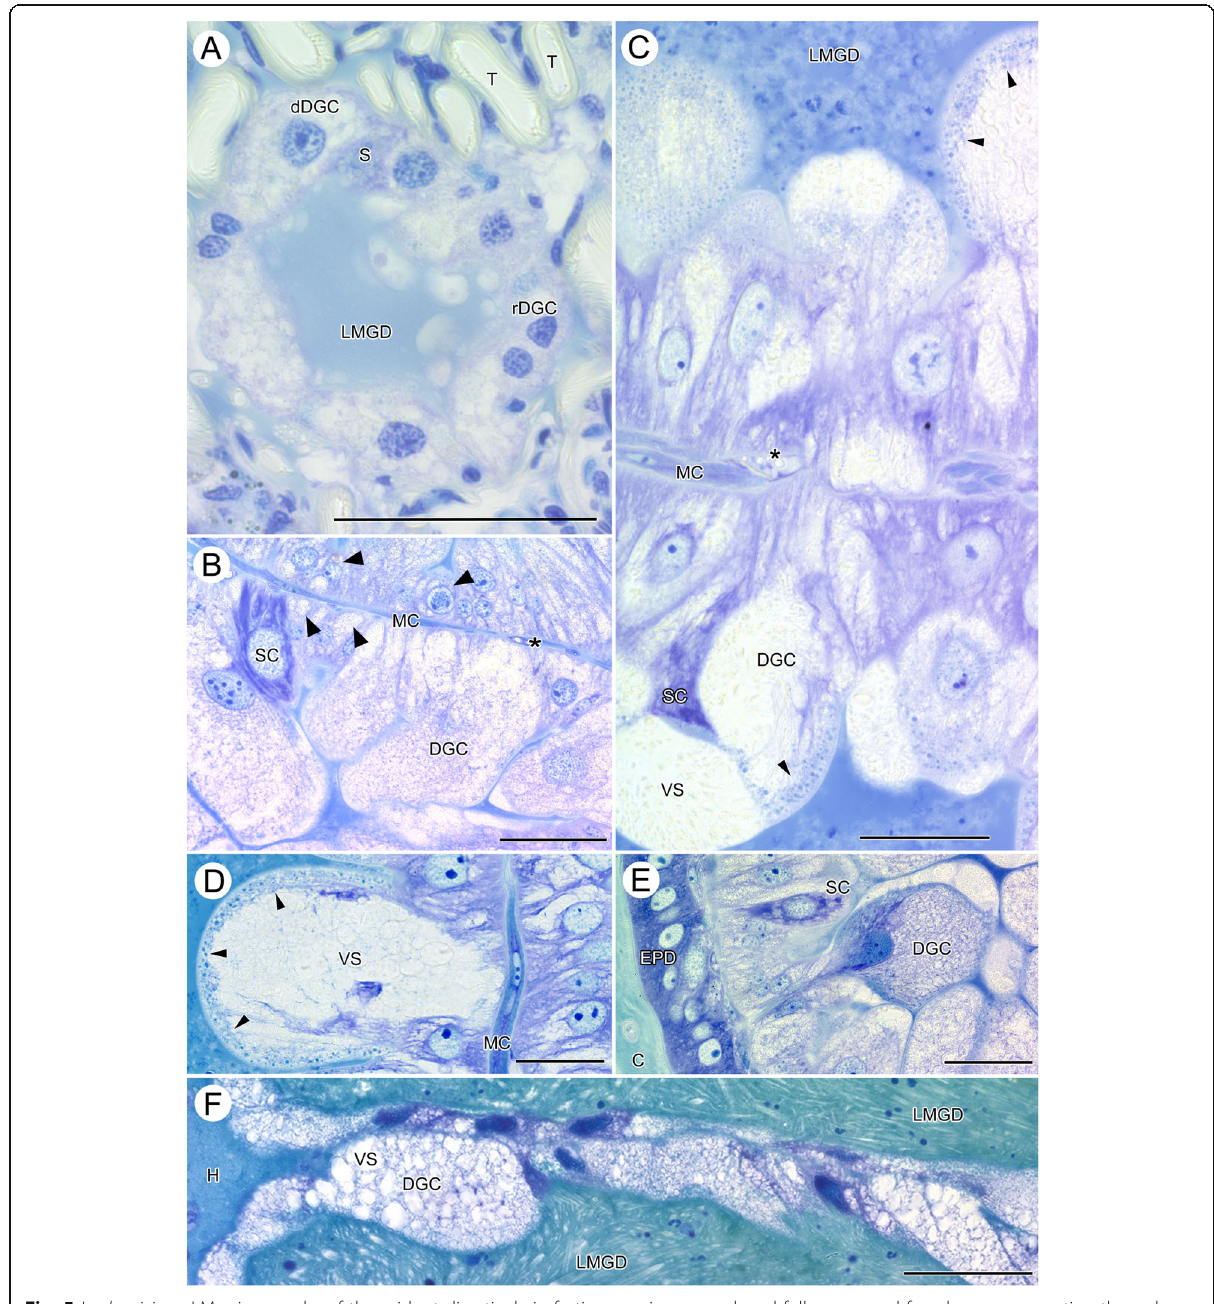
Fig. 5 Ixodes ricinus, LM micrographs of the midgut diverticula in fasting, semi-engorged, and fully engorged females. a cross-section through a midgut diverticulum of a fasting tick. b Epithelium of two neighboring midgut diverticula of an early feeding stage tick. c Epithelium of two neighboring midgut diverticula of a semi-engorged tick. d High-power micrograph of an individual digestive cell in the epithelium of a midgut diverticulum of a semi-engorged tick. e High-power micrograph of the epithelium of a midgut diverticulum directly under the epidermis ( f ) Epithelium of two adjoining midgut diverticula of a fully engorged tick. Abbreviations : C, cuticle; dDGC, degenerative digestive cell; DGC, digestive cell; EPD, epidermis; H, hemolymphatic space; LMGD, lumen of the midgut diverticula; MC, muscle cell; rDGC, resting digestive cell; S, stem cell; SC, secretory cells; T, trachea; VS, vesicles; arrowheads point to the marginal zone of small, intensively staining vesicles. All scale bars 50 μ